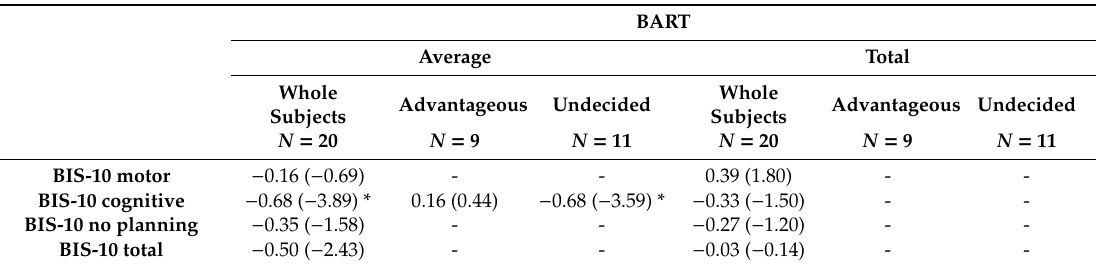
Table 2. Spearman’s correlation between BART scores (average and total number of adjusted pumps) and (Barratt Impulsiveness Scale version 10) BIS -10 scores. Spearman R values are followed by t values in brackets. * p < 0.01. When significance was obtained for the overall group of participants, additional significance was analyzed for the favorable and undecided groups.